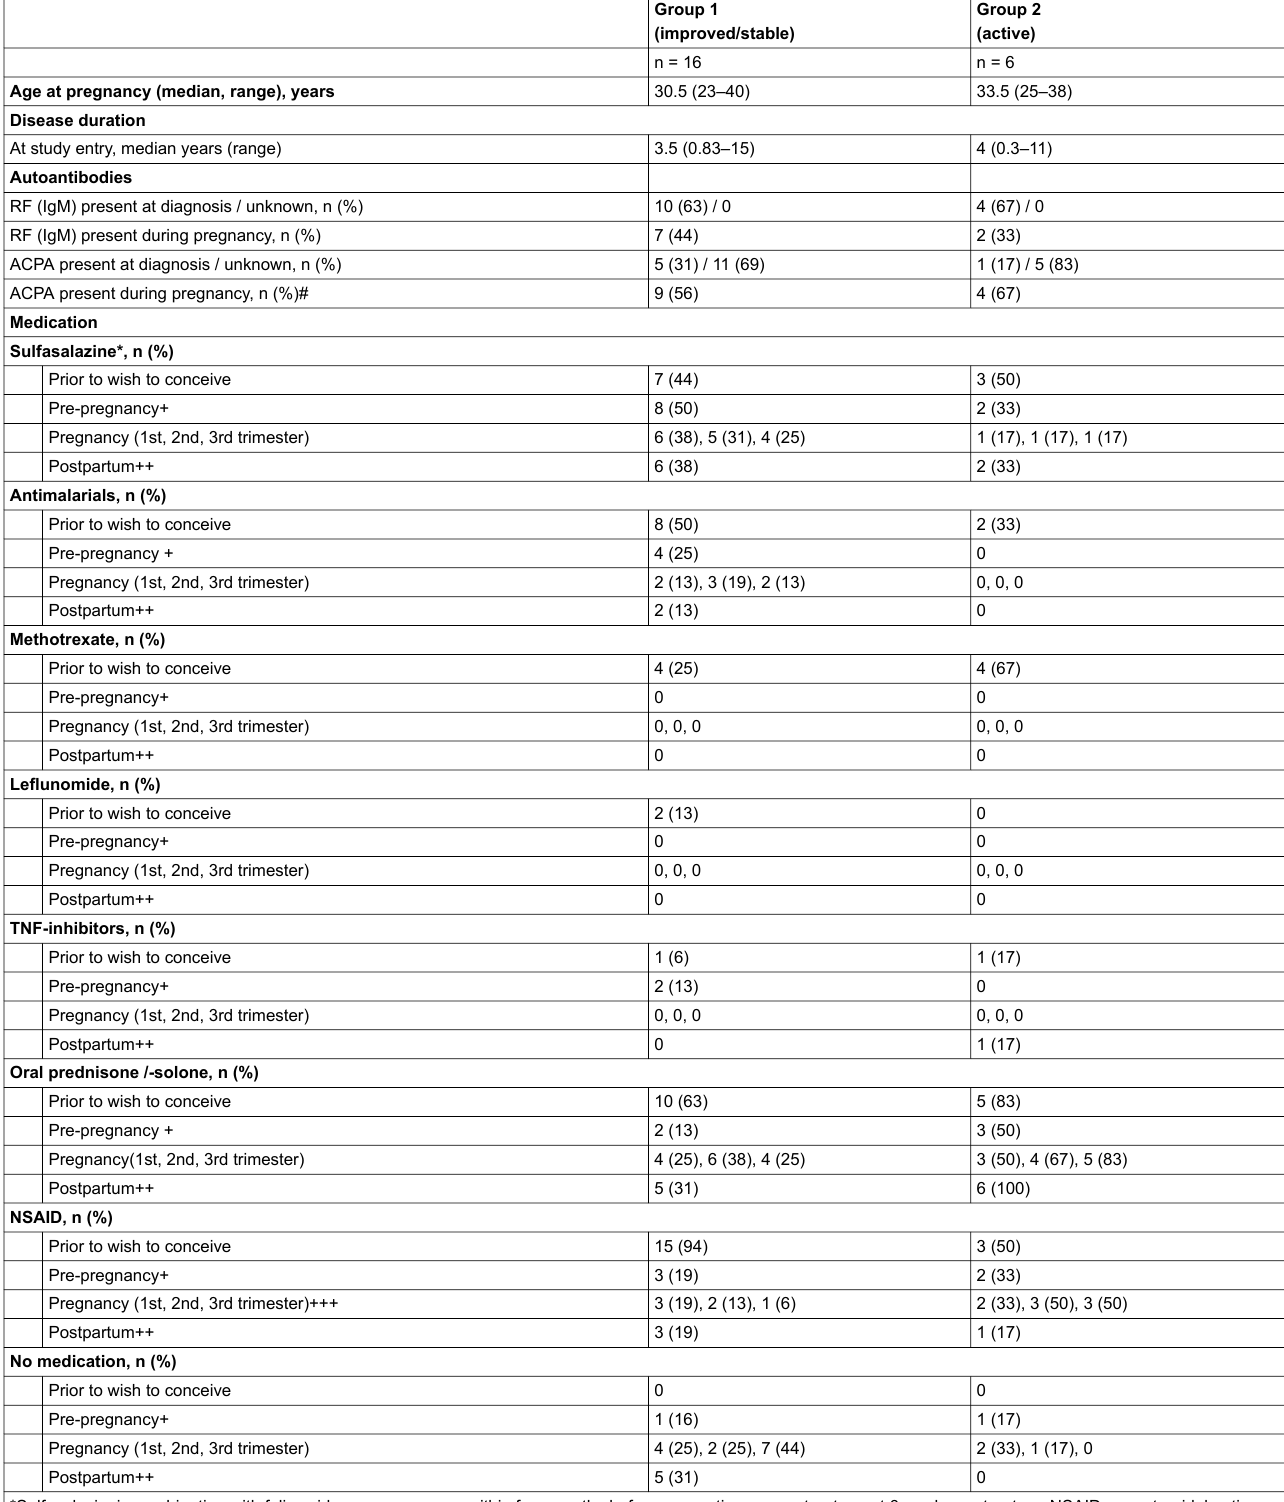
Table 1: Patient’s characteristics and medication before, during and after pregnancy.